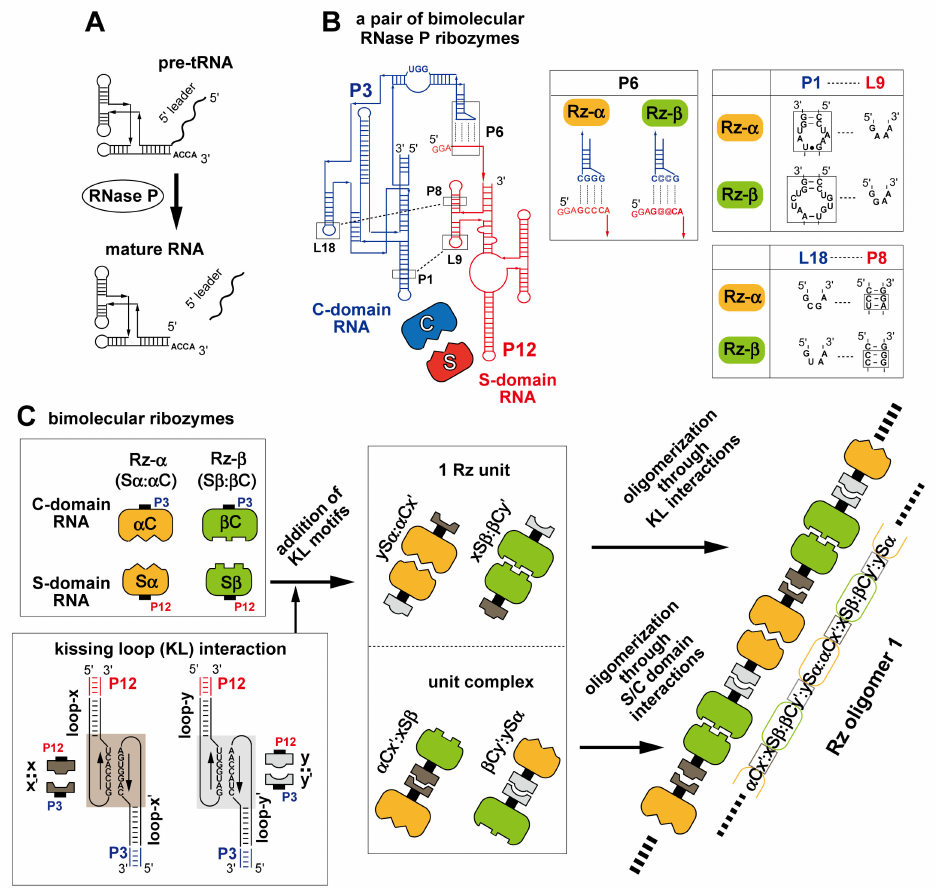
Figure 1. Reaction, modular structure, and assembly of RNase P ribozymes. ( A ) Removal of the 5 (cid:48) leader sequence of pre-tRNA catalyzed by RNase P enzymes. ( B ) Secondary structure of a bimolecular bacterial RNase P ribozyme consisting of the S-domain RNA (shown in red) and C-domain RNA (shown in blue). Broken lines indicate tertiary structures participating in noncovalent assembly between the C-domain and S-domain. Assembly of the two-domain RNAs was mediated by a trio of tertiary interactions (P1–L9, L18–P8, and P6), by which RNA–RNA assembly interfaces between the C-domain and S-domain were defined and supported. ( C ) Scheme of modular engineering to generate bimolecular RNase P ribozymes possessing KL motifs enabling co-oligomerization to yield Rz oligomer